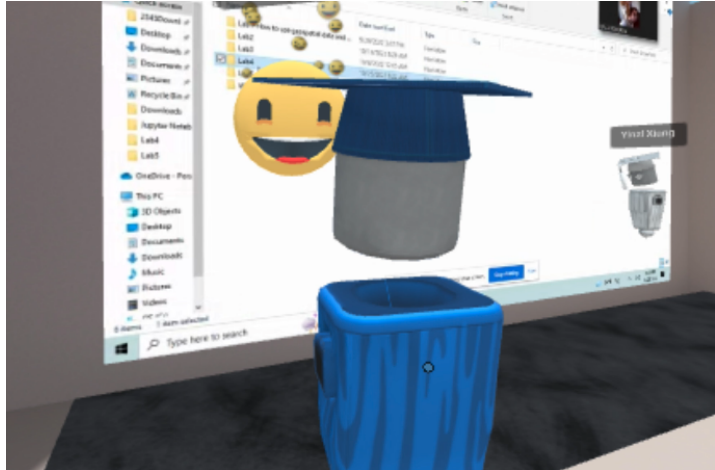
Figure 6. Student’s happy emotion captured and sent as an emoji